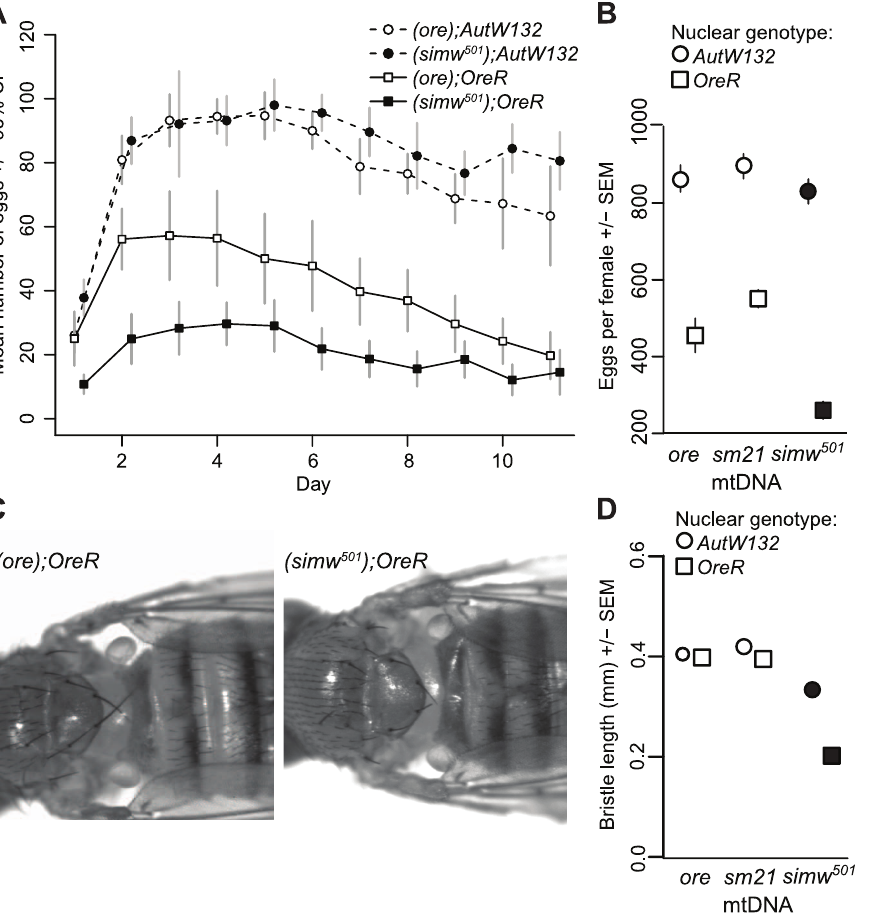
Figure 2. Effects of a mitochondrial–nuclear interaction on adult fecundity and sensory structures. (A) The simw 501 mtDNA decreases the total number of eggs females laid by 50% only in the OreR nuclear background (mtDNA 6 nuclear interaction: F =9.772, P =0.004, N =6–11 females per genotype). There is a main effect of the nuclear genome on fecundity, presumably because OreR and AutW132 are from different populations and differ at thousands of loci across their genomes. (B) A second experiment reveals the same significant mitochondrial-nuclear interaction ( P ANOVA =0.001, Table S1) and also shows that the closely related D. simulans mtDNA sm21 does not decrease fecundity in either nuclear background. (C) The simw 501 mtDNA shortens adult mechanosensory bristles by 50% in the OreR nuclear background. (D) Measurement of the posterior scutellar bristles reveals a significant mitochondrial-nuclear interaction effect on bristle length ( P ANOVA # 0.001, Table S1). There was no sex-by-genotype interaction, and sexes are pooled in this plot. Some error bars are smaller than the symbols.